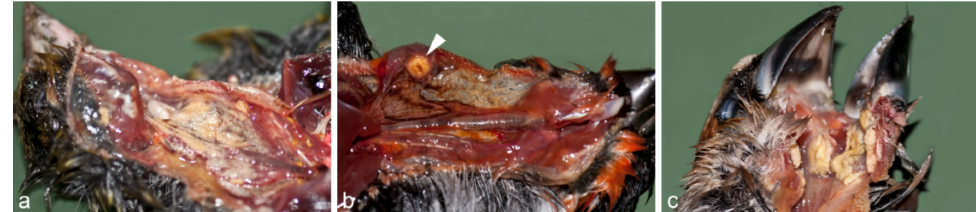
Figure 2. ( a ) Diphtheritic pseudomembrane affecting the esophagus, crop and pharynx of a green- finch as multifocal to coalescing nodules in the crop obstructing the lumen; ( b ) Focal diphtheritic pseudomembrane of a bullfinch as a single nodule in the crop mucosa; ( c ) Hawfinch with extensive diphtheritic pseudomembrane affecting the